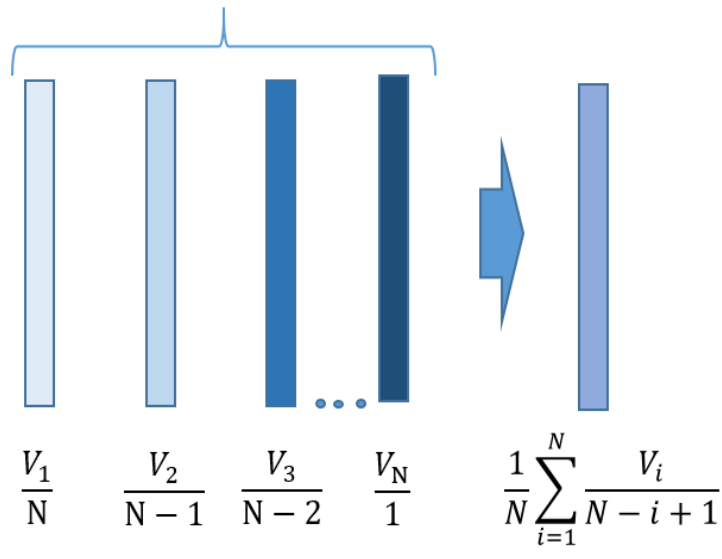
Figure 4. Sequence-based